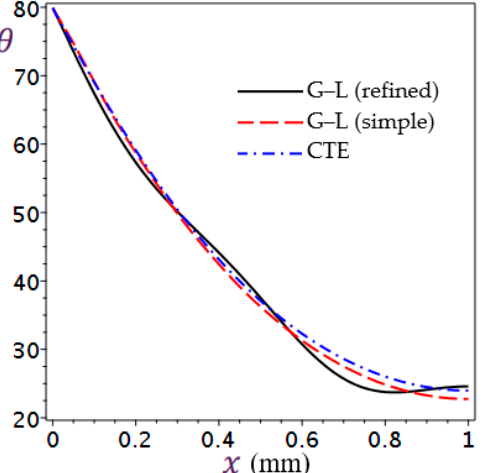
Figure 2. Two-dimensional plots of temperature 𝜃 distributions in different theories of thermoelasticity.